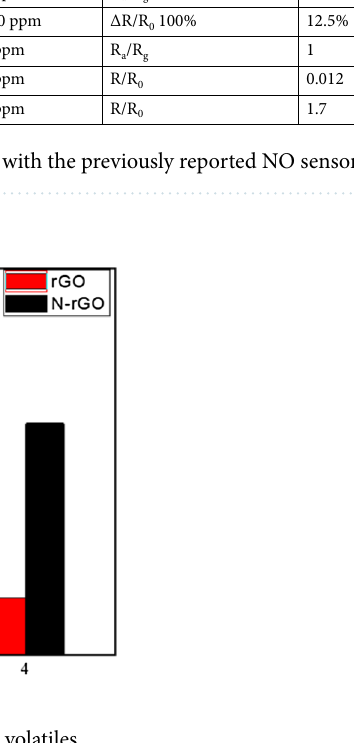
Figure 11. Selectivity of the sensor to other organic